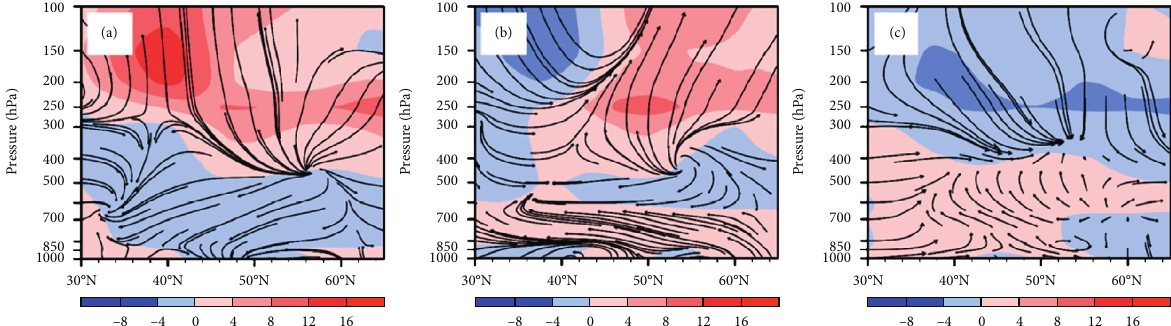
Figure 11: Meridional-vertical cross-sections of PV anomalies (shadow, unit: PVU, 1 PVU � 10 − 6 m 2 · s − 1 K · kg − 1 ) and meridional wind (vectors) along 125 ° E for NCVs in (a) late spring and (b) early autumn and MCVs in (c)